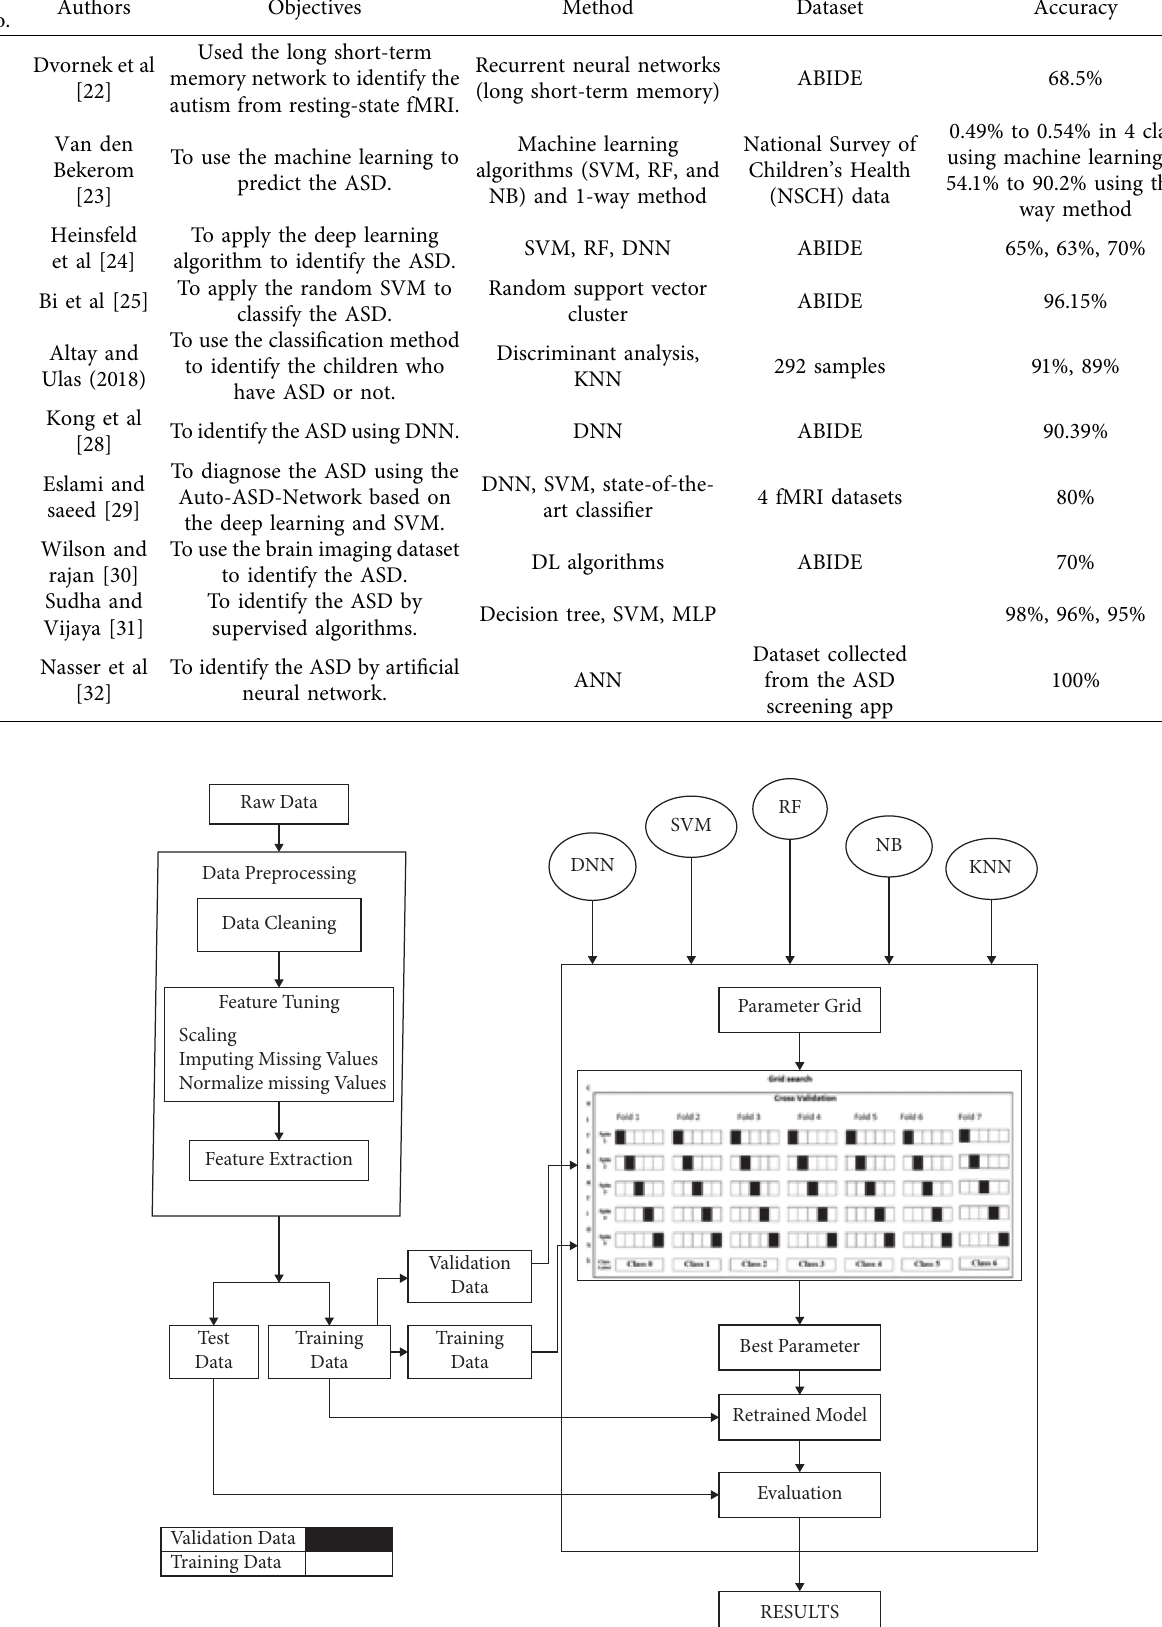
Figure 1: Proposed